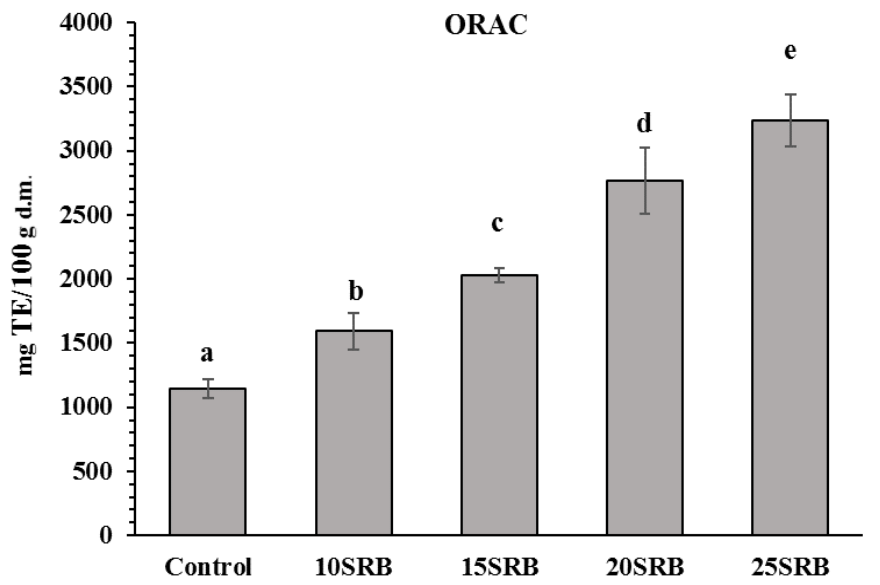
Figure 3. Antioxidant activity in white wheat bread with stabilized rice bran (SRB) (n = 3). Abbreviations: 10SRB, formulation with 10% of SRB; 15SRB, formulation with 15% of SRB; 20SRB, formulation with 20% of SRB; 25SRB, formulation with 25% of SRB. The different lowercase letters indicate significant difference among mean values ( p ≤ 0.05 according to Duncan’s